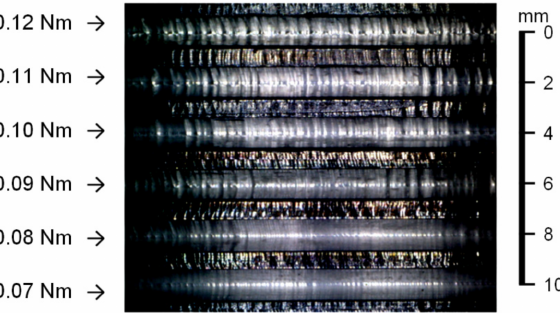
Figure 7. Results of the thread milling experiments on the AL6061 workpiece (preset torque command changed in the range of 0.07–0.12